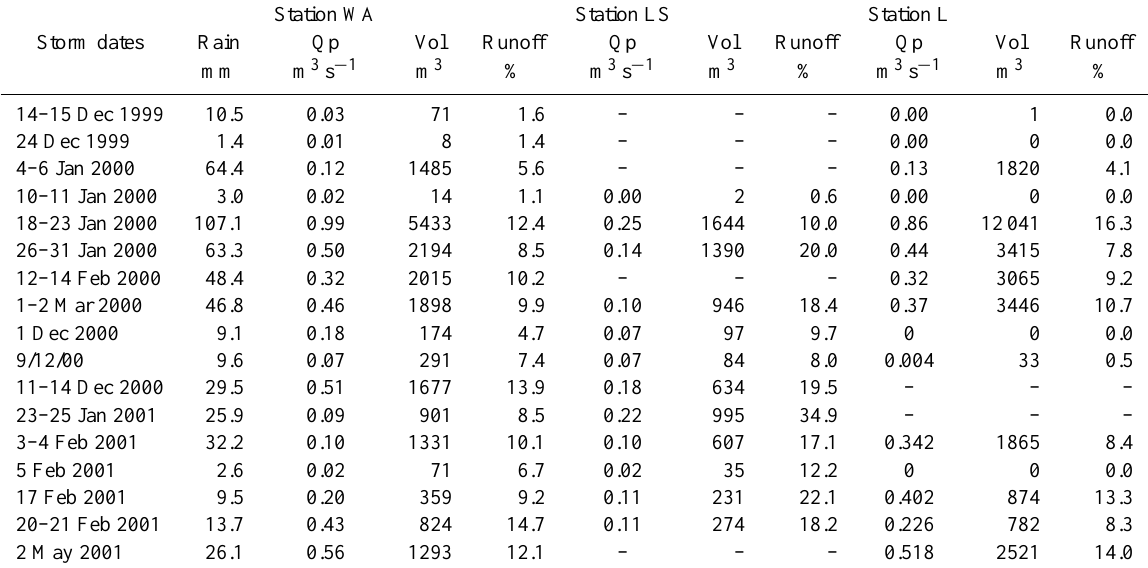
Table 4. Storm events in Ramallah during winter seasons 1999/2000 and 2000/2001.